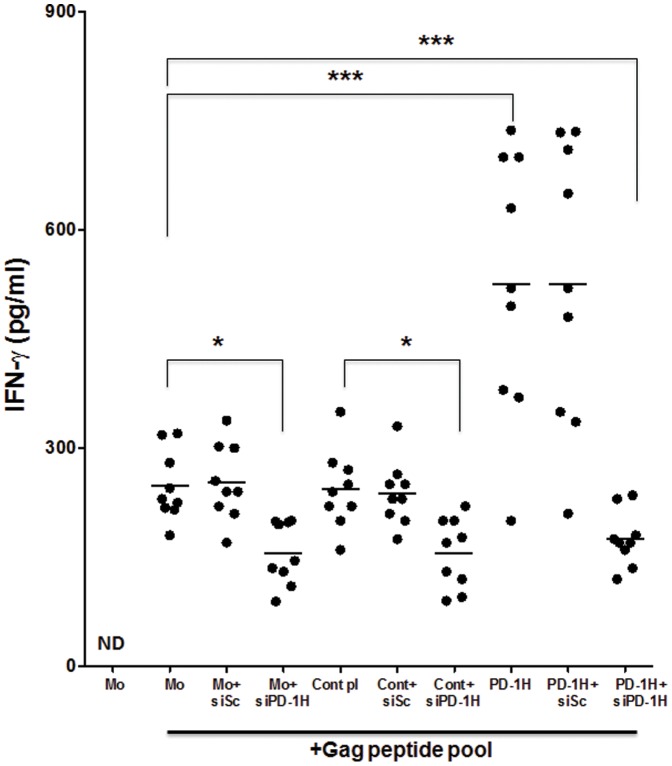
Stimulation with PD-1H- overexpressing monocytes enhances HIV gag-specific IFN-γ response by T cells.Monocytes from HIV-infected individuals were untreated or nucleofected with control plasmid or PD-1H expression plasmid in presence of scrambled siRNA or PD-1H siRNA. After 24 h of transfection, the monocytes were pulsed with HIV clade B gag peptide pool, and used to stimulate autologous T cells. After overnight stimulation, IFN-γ secretion was measured by ELISA. Each symbol represents an individual HIV donor. Mo  =  monocytes. No pep  =  stimulation with monocytes without peptide. ND =  not detected. siSc  =  transfection with control scrambled siRNA; siPD-1H  =  transfection with PD-1H siRNA. Control pl  =  transfection with control plasmid; PD-1H pl  =  transfection with PD-1H expression plasmid.